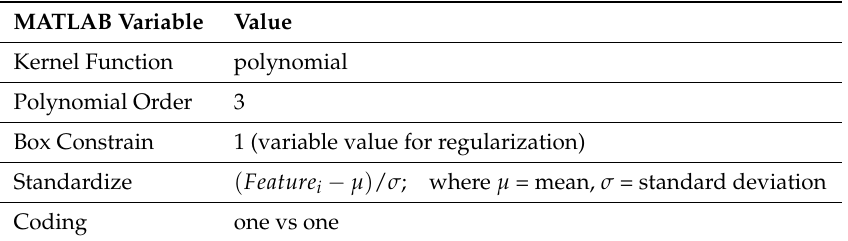
Table 1. Support vector machine (SVM)